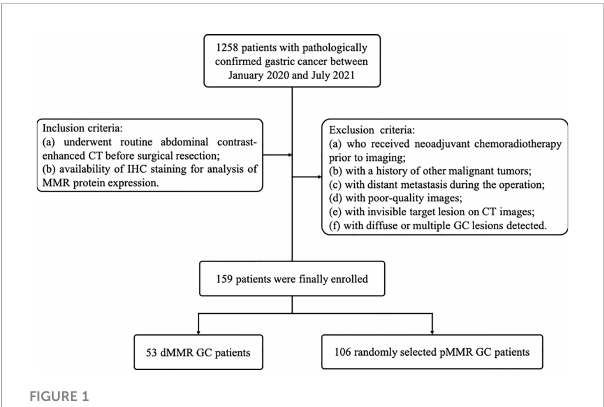
FIGURE 1 Flowchart of the patient selection and patient